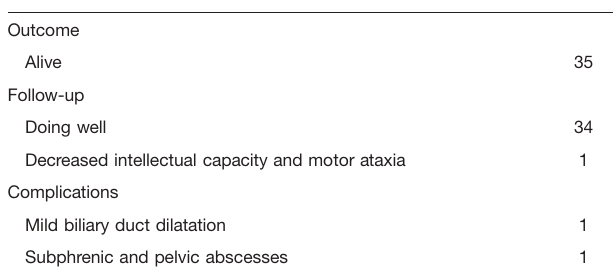
TABLE 1 | Summary of the clinical characteristics ( n